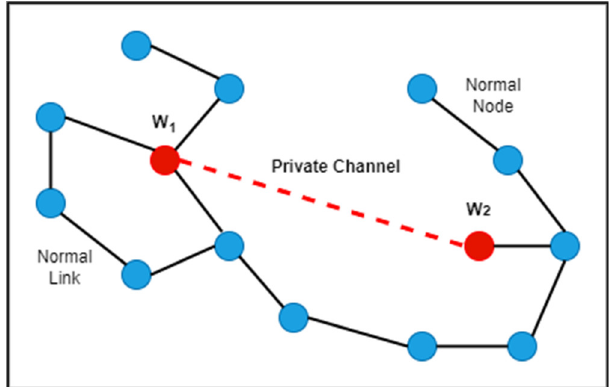
Figure 2. External wormhole attack with high power transmission.